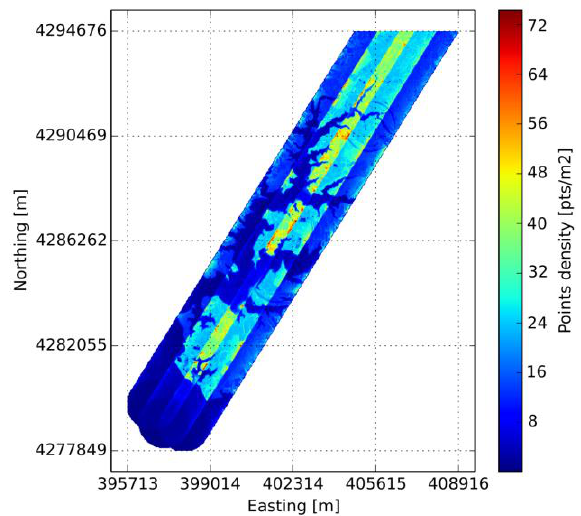
Figure 6. Extent of Easton dataset flight lines (note, data has been sub-sampled to enable visualisation)